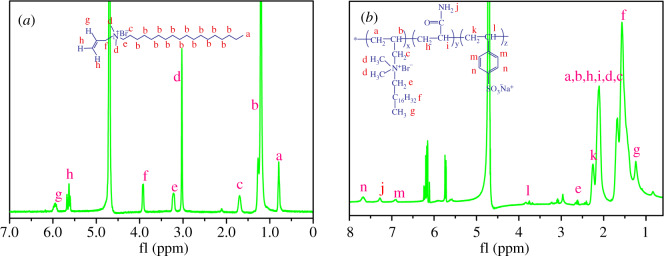
1HNMR (in D2O) spectrum of (a) DOAAB and (b) ADOS.